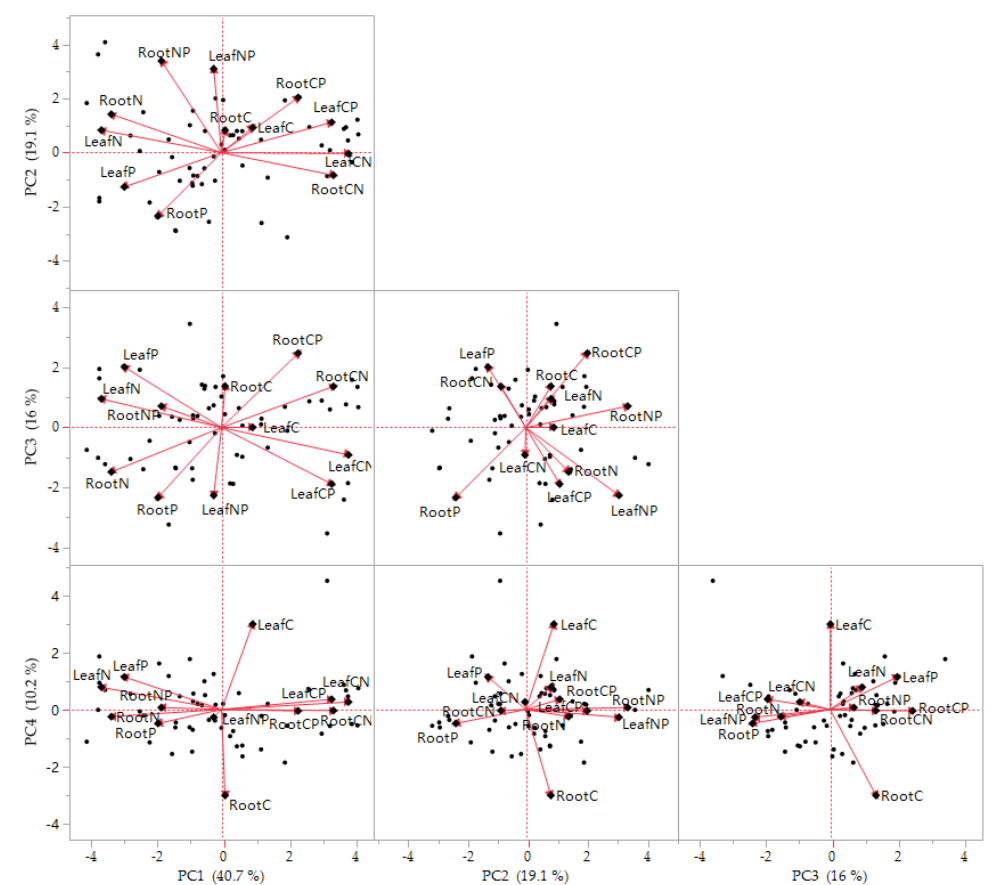
Figure 2. Trait dimensions from the first four principal components (PCs) of the principal component analysis. The PCA data showed four independent axes representing the stoichiometry of the leaves and roots in the karst shrubs (Figure 2; Table A3). The first four principal components collectively accounted for 86.11% of the total variation, whereas the fifth principal component further accounted for 6.27%. The first PC, which was predominantly related to leaf N, leaf P, root N, leaf C:N, leaf C:P, and root C:N, accounted for 40.73% of the total variation, whereas PC 2 and 3 together accounted for 35.19% of the total trait variation, indicating that root P, leaf N:P, root C:P, and root N:P dominated these PCs. PC 4, which accounted for 8.810.19% of all the trait variation, was found to be dominated by leaf C and root C (Table A3). 3.3. Factors Affecting the Stoichiometry in the Karst Shrub Factor analysis of variance demonstrated that the differences in species had a high explanatory power in terms of the stoichiometry of the shrub leaves and roots (Table 5). Coefficient of determination ( R 2 ) values between the species and the stoichiometry of the shrub leaves and roots ranged between 0.07 and 0.63. Among the variables, the differences in species significantly explained the variation in terms of the stoichiometry in the leaves and roots, except in the case of leaf C and root C:P. In addition, the different soil nutrients had a small effect on the variation of the stoichiometry of the shrub leaf and root, except for the leaf N, leaf N:P, and root C:P. Then, the effect of the topography on the variation of the stoichiometry of the shrub leaf and root was smallest, except in the case of leaf N ( p < 0.05; Table 5). Therefore, the model of combining species and soil nutrient characteristics can already reflect most stoichiometric changes, especially in leaf N and Leaf P. The full